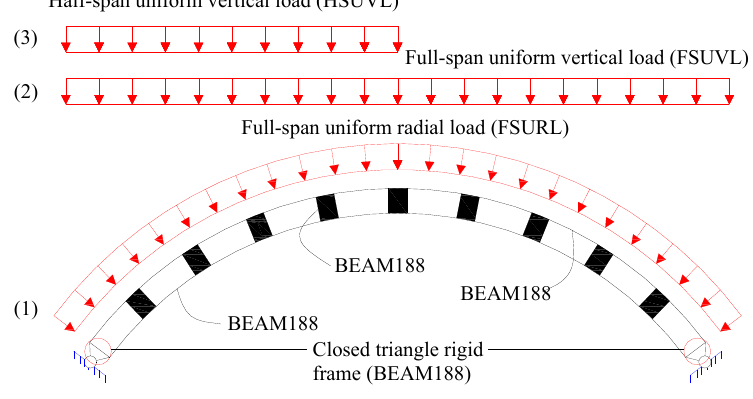
Figure 4. Load cases considered in this study.